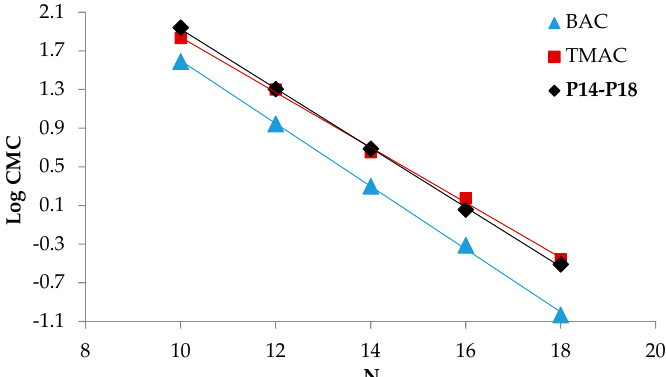
Figure 5. Graphical presentation of the Klevens equation for P14 – P18 , TMAC and BAC (N = alkyl chain length).